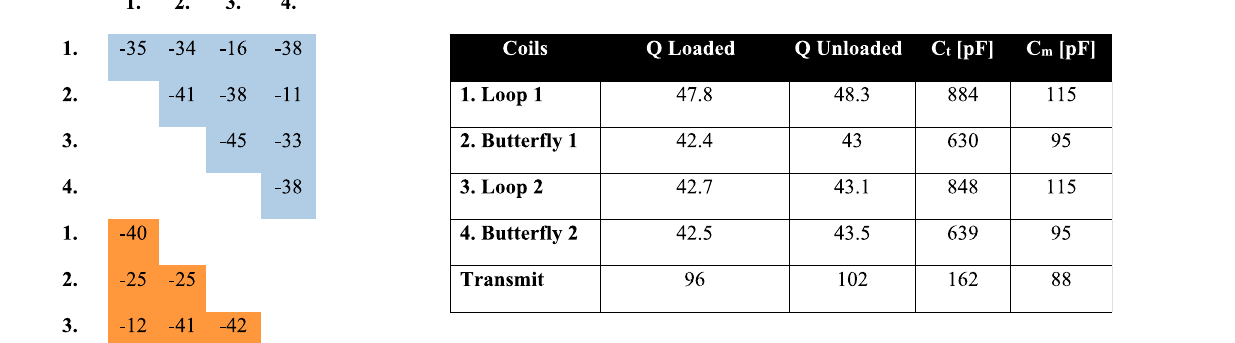
TABLE 2 | Left) Simulated (blue) and measured (orange) S-parameter matrix (dB) under loaded conditions. Right) Loaded and unloaded Q values for the Tx coil and Rx coils includingtuningandmatchingcapacitorvalues.VariablecapacitorswereusedinparallelwithallCtandCmexceptfortransmitcoilwherethevariablecapacitorisadded to one of the segmentations. The numbers in the left part of the table correspond to the coils in the right part of the table.